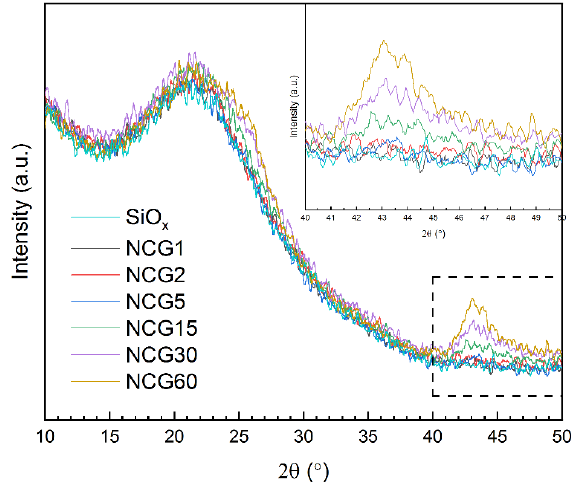
Figure 1. X-ray diffractograms of the low-temperature oxide (LTO) reference wafer and the nanocrystalline graphite (NCG) samples grown at different time periods. (Inset: enhancement of the dotted square, evidencing the C(10) peak at 2 θ = 43°). The spectra are smoothed with the Savitzky-Golay method over an 11-point window, with a second-order polynomial, for better differentiation of the lines.